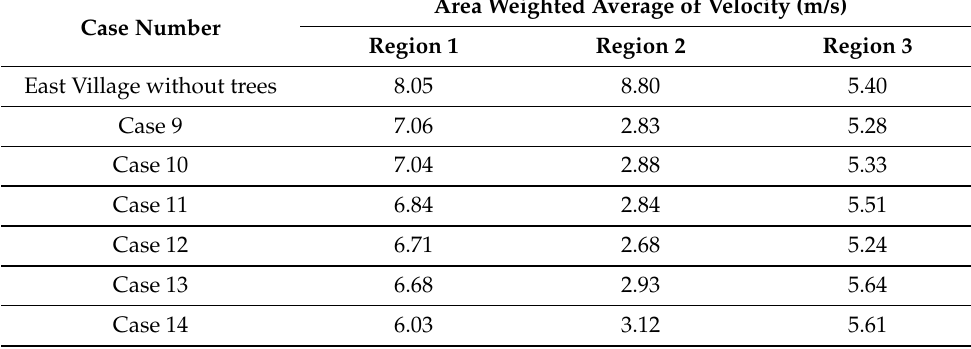
Table 5. Area weighted average of velocity for regions 1, 2 and